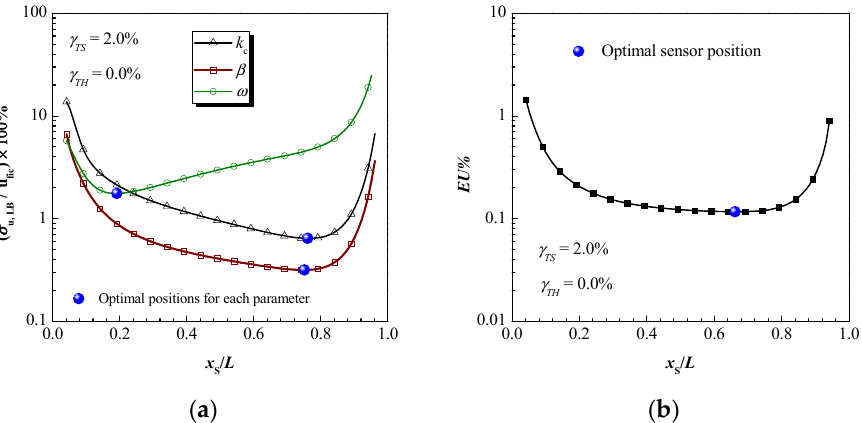
Figure 7. The values of ( a ) σ u ,LB / u fic and ( b ) EU % as a function of the dimensionless sensor location